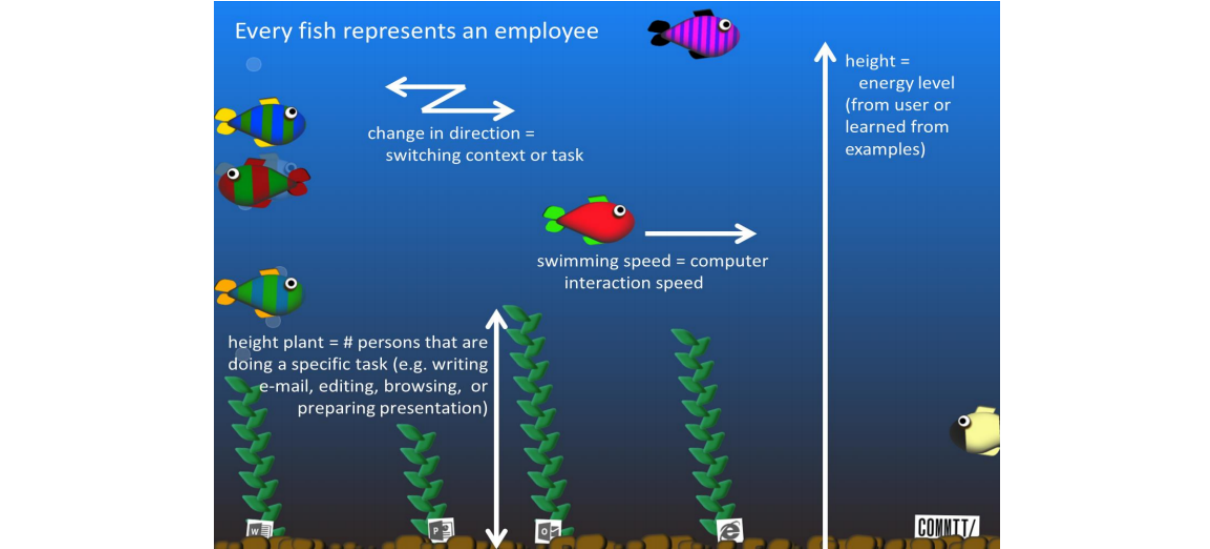
Figure 11. Screen image of the SWELL Fishualization placed in the coffee